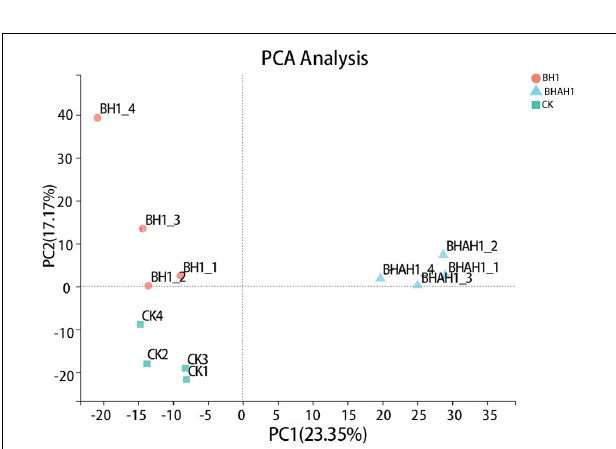
FIGURE 4 | Principal component analysis was performed using the expression levels of unigenes. The horizontal and vertical axes represent the contributions of principal components N (PCN) and M (PCM), respectively, in the two-dimensional graph to the discrimination of samples. Orange dots, C. japonica immersed in berberine hydrochloride; green squares, control group; blue triangles, C. japonica immersed in berberine hydrochloride and injected with A. hydrophila .